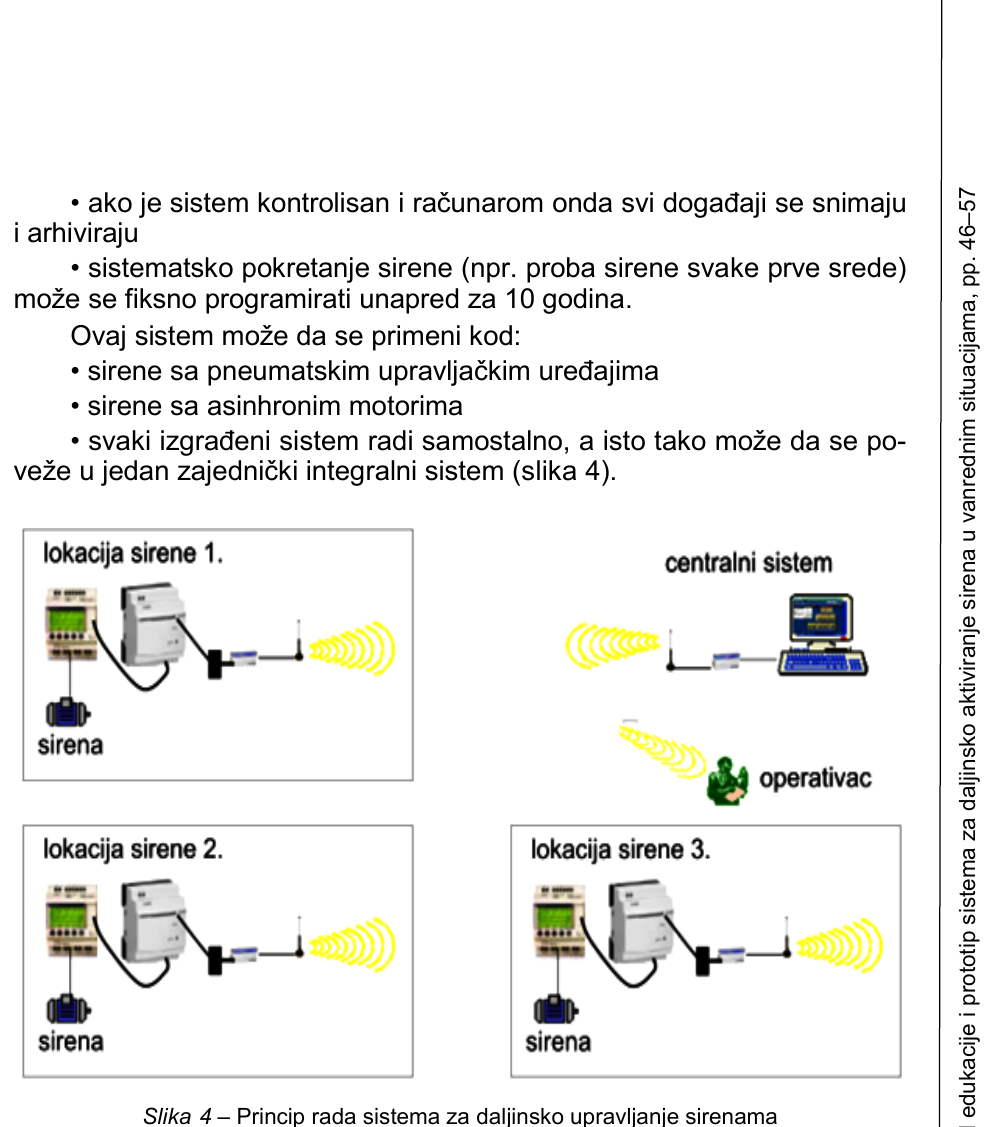
Figure 4 – Principle of the operation of the siren remote control system Model nastavne teme